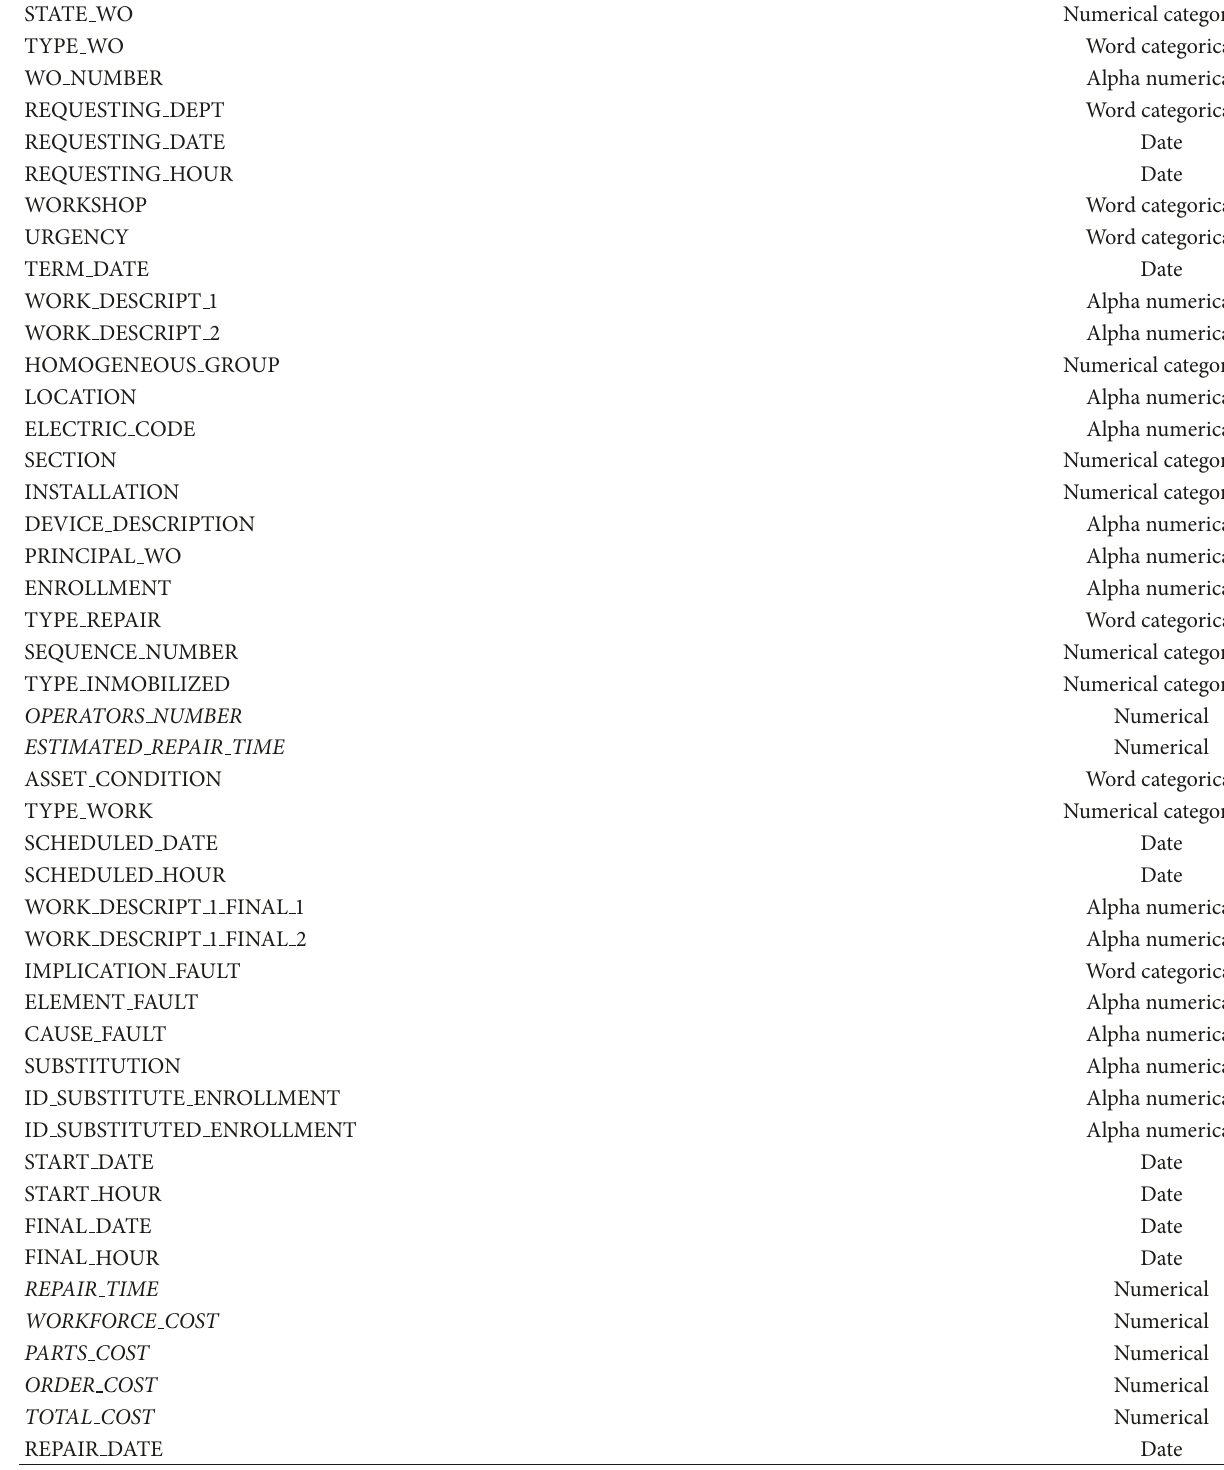
Table 1: Original attributes of the maintenance work